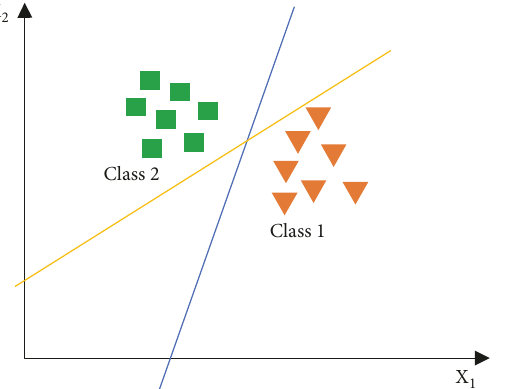
Figure 4: Illustration of finding the best hyperplane between two classes.